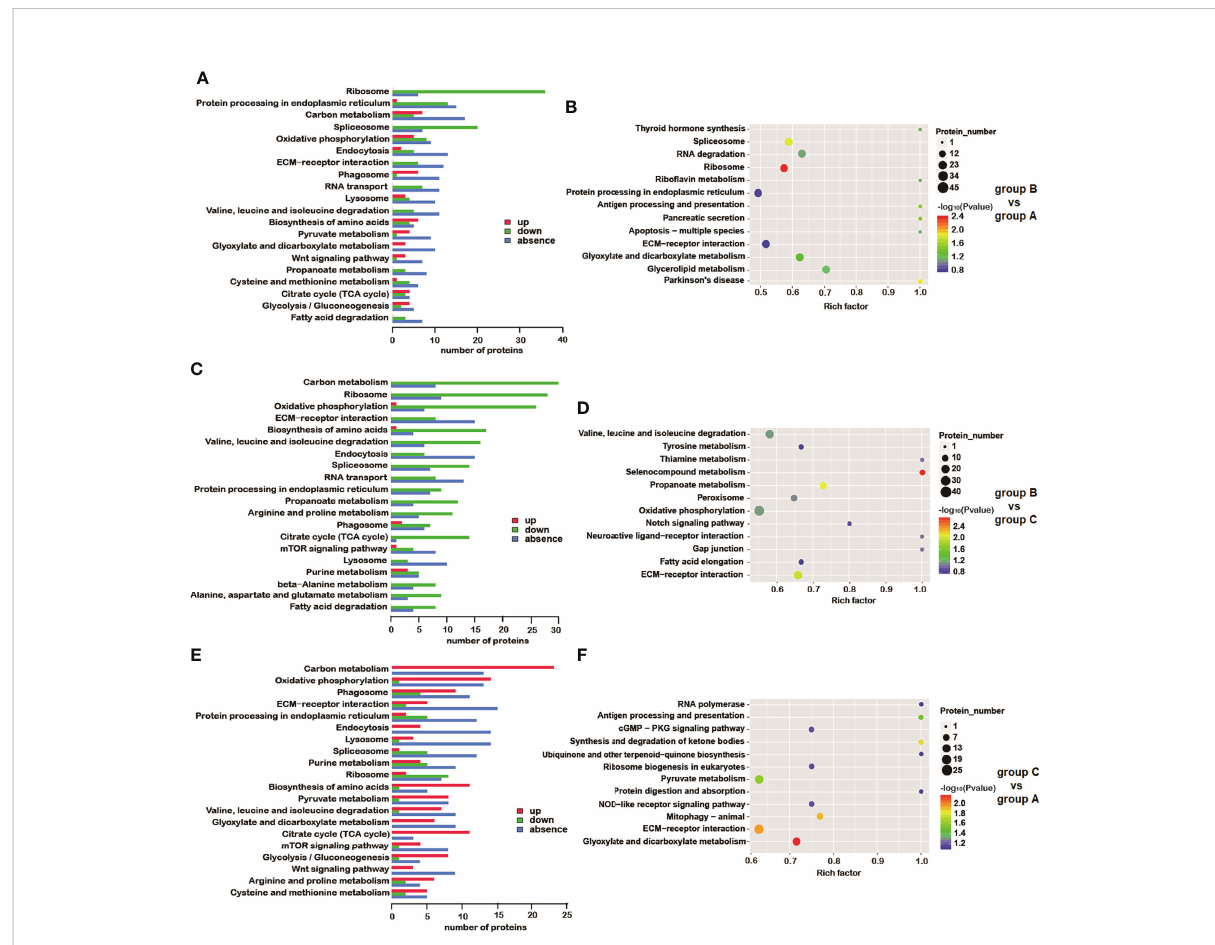
FIGURE 5 KEGG analysis of DEPs. Results of KEGG annotation in group B vs group A (A) , group B vs group C (C) and group C vs group A (E) . Up- and down-regulated proteins (red and green, respectively) as well as unique (blue) proteins are indicated in the pathways. KEGG enrichment of differentially expressed proteins is shown for comparisons between group B vs group A (B) , group B vs group C (D) and group C vs group A (F) . The color of spots indicates the signi fi cance level related to differences between each group. Gene names can be found in KEGG by searching gene